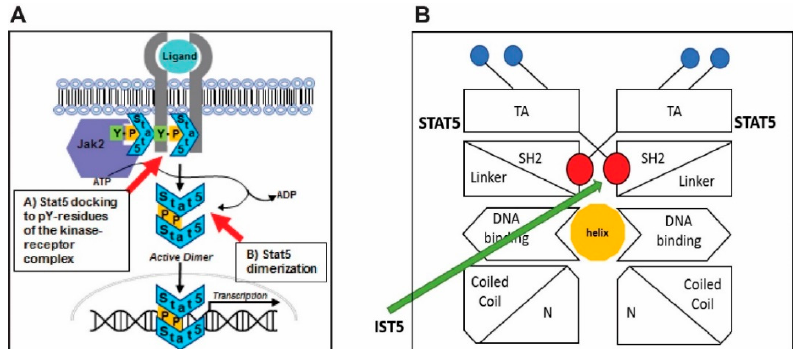
leads to suppression of Stat5 phosphorylation and activation. Second, the SH2-domain of a phosphorylated Stat5 monomer binds the phosphorylated Y694/699 residue of the partner Stat5 to form a transcriptionally active parallel dimer, which translocates to the nucleus to regulate transcription [36,38,41] (Figure 1A). In other words, also the dimerization of Stat5 dimerization is mediated by the SH2-domain of Stat5.